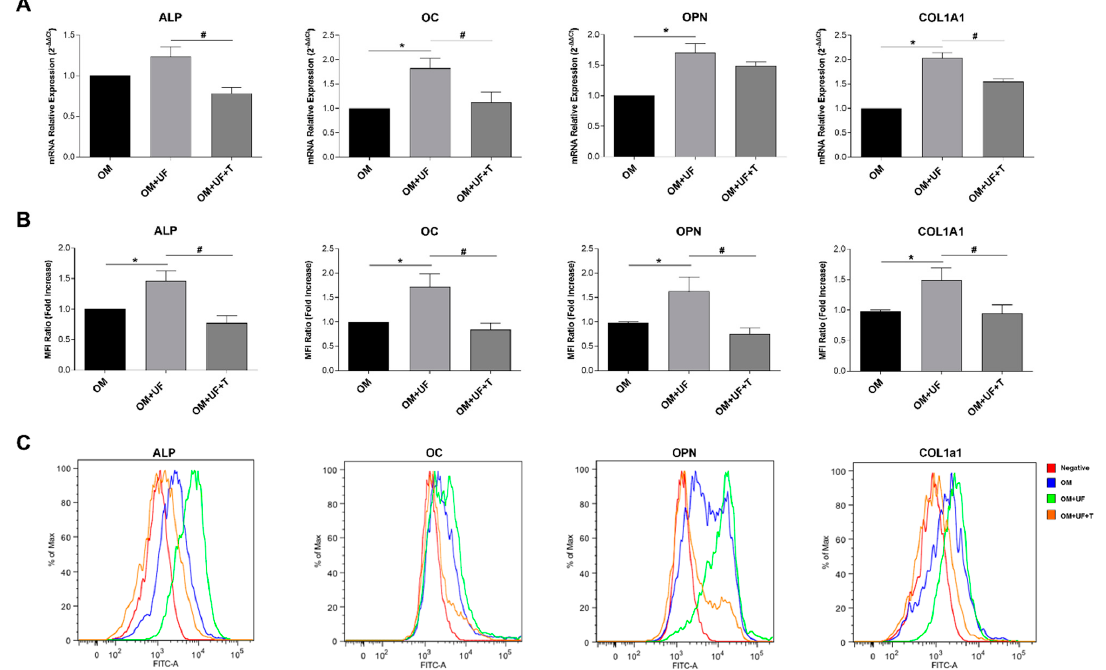
and protein expression (Figure 4B,C) of ALP, OC, OPN, and COL1a1 induced by UF (10 vs. OM).